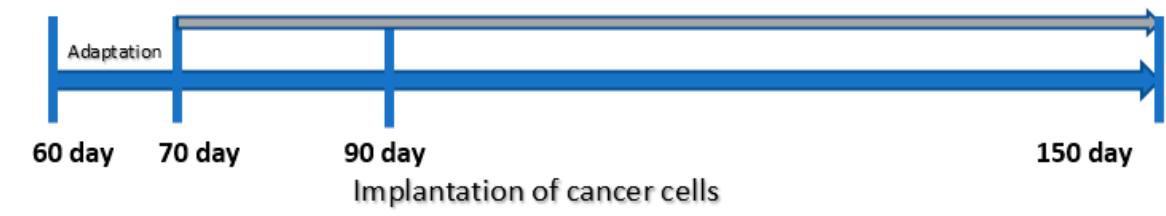
Figure 1. Scheme of the experimental procedure.